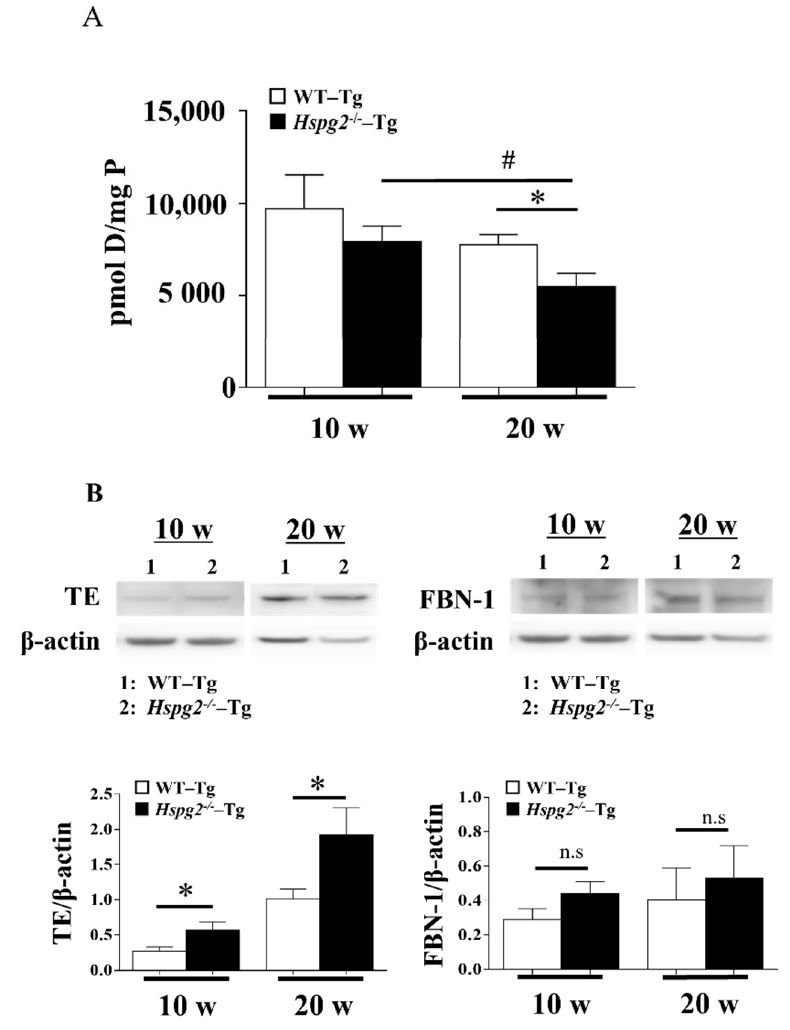
Figure 8. Maturity of elastic fiber in aortic tissue. ( A ) The amount of desmosine, an indicator of elastic fiber maturity, was evaluated with an amino acid analysis. The amount of desmosine in the aortic tissue of 20-week-old Hspg2 − / − -Tg mice without AD was significantly decreased compared to that in age-matched WT-Tg mice or 10-week-old Hspg2 − / − -Tg mice (Mean ± SEM, n = 5, # p , * p < 0.05 vs. Hspg2 − / − -Tg at 20 weeks). ( B ) Immaturity of elastic fibers was evaluated by western blotting with anti-tropoelastin(TE), soluble precursor elastin, antibody, or anti-fibrillin-1 antibody. Each band was quantified using ImageJ software and is shown relative to β -actin. Soluble tropoelastin in Hspg2 − / − -Tg mouse aortic tissue was significantly increased compared to that in WT-Tg mice (Mean ± SEM, n = 3, # p , * p < 0.05 vs. WT-Tg,